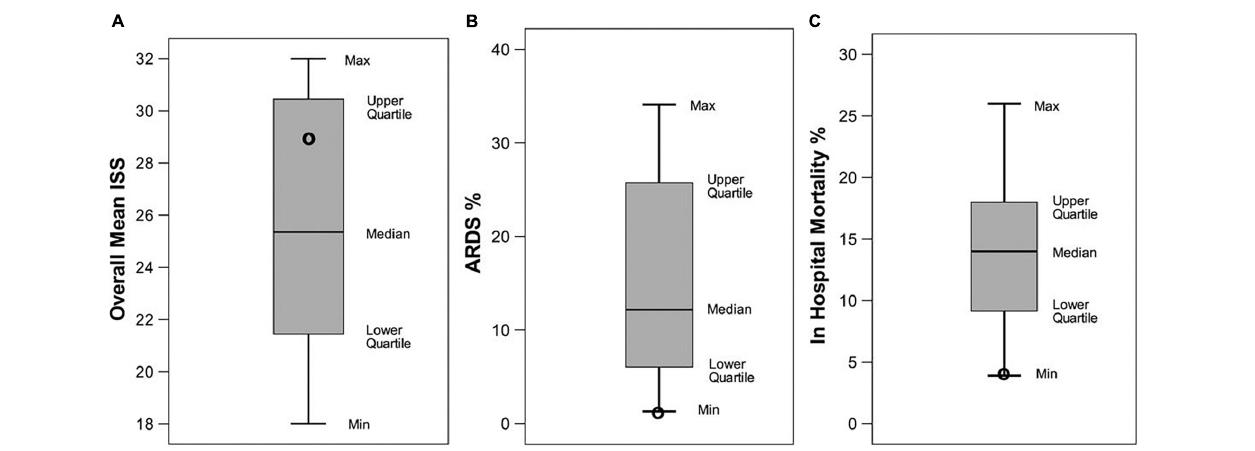
FIGURE 12 | A systematic review of data from trauma patients who were ventilated with either conventional mechanical ventilation (CMV) or the time-controlled adaptive ventilation (TCAV) method using the airway pressure release ventilation (APRV) mode. Boxplots are mean and standard error for (A) Injury Severity Score (ISS), (B) percentage of patients who developed ARDS (ARDS%), and (C) in-hospital mortality (%) from 16 published papers using standard of care CMV. Black circles indicate the results in each category using the TCAV method at the R Adam Cowley Shock Trauma Center in Maryland. Although patients in the TCAV group were in the high-ISS range, they had the lowest levels of both ARDS incidence (ARDS%) and in-hospital mortality (%) as compared with patients ventilated using CMV (Andrews et al., 2013). Permissions obtained from Wolters Kluwer Health, Inc. License